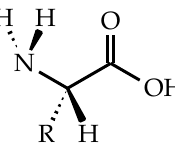
Figure 1. General structure of an L -amino acid that shows the characteristic amine (-NH 2 ) and